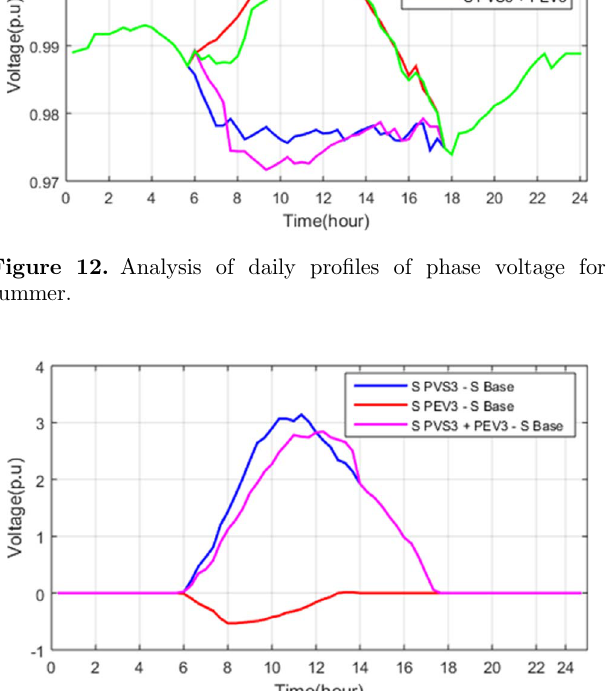
Figure 13. Analysis of daily pro fi les of phase voltage for summer in relation of base